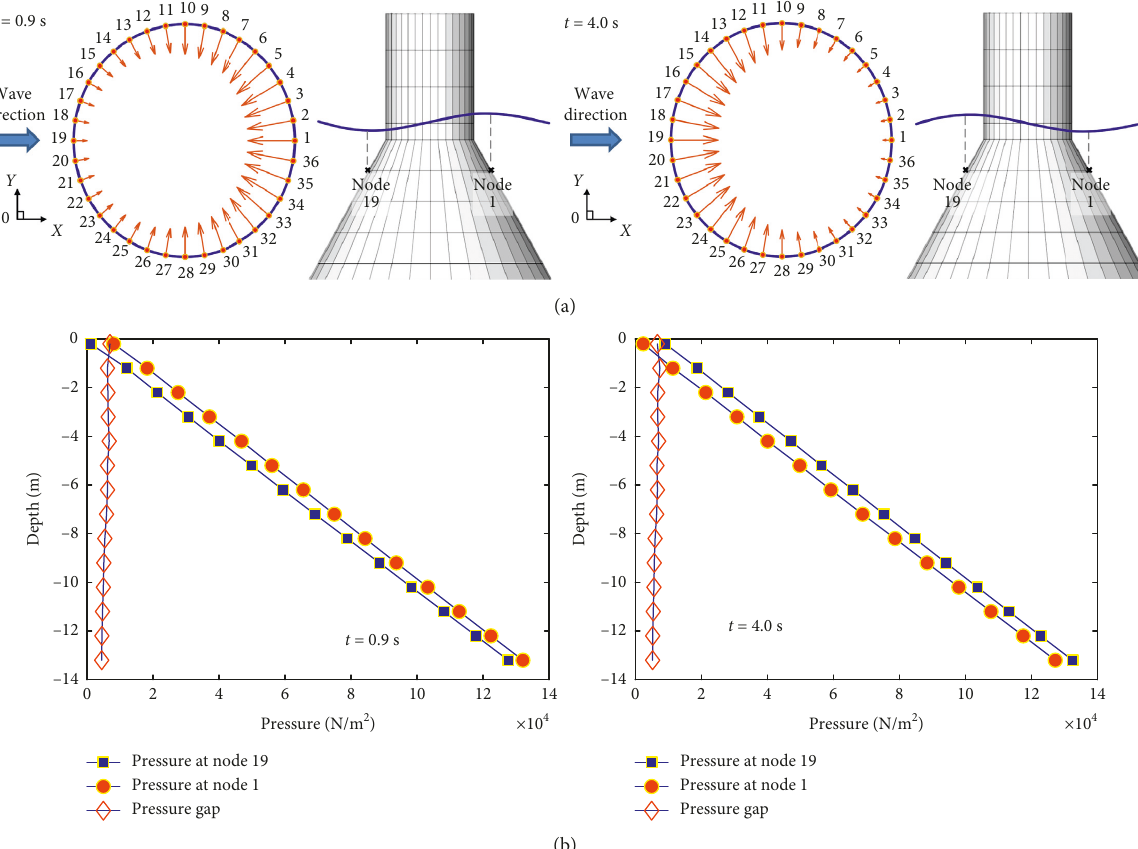
Figure 7: Wave pressure on the caisson foundation at t pressure vs depth.